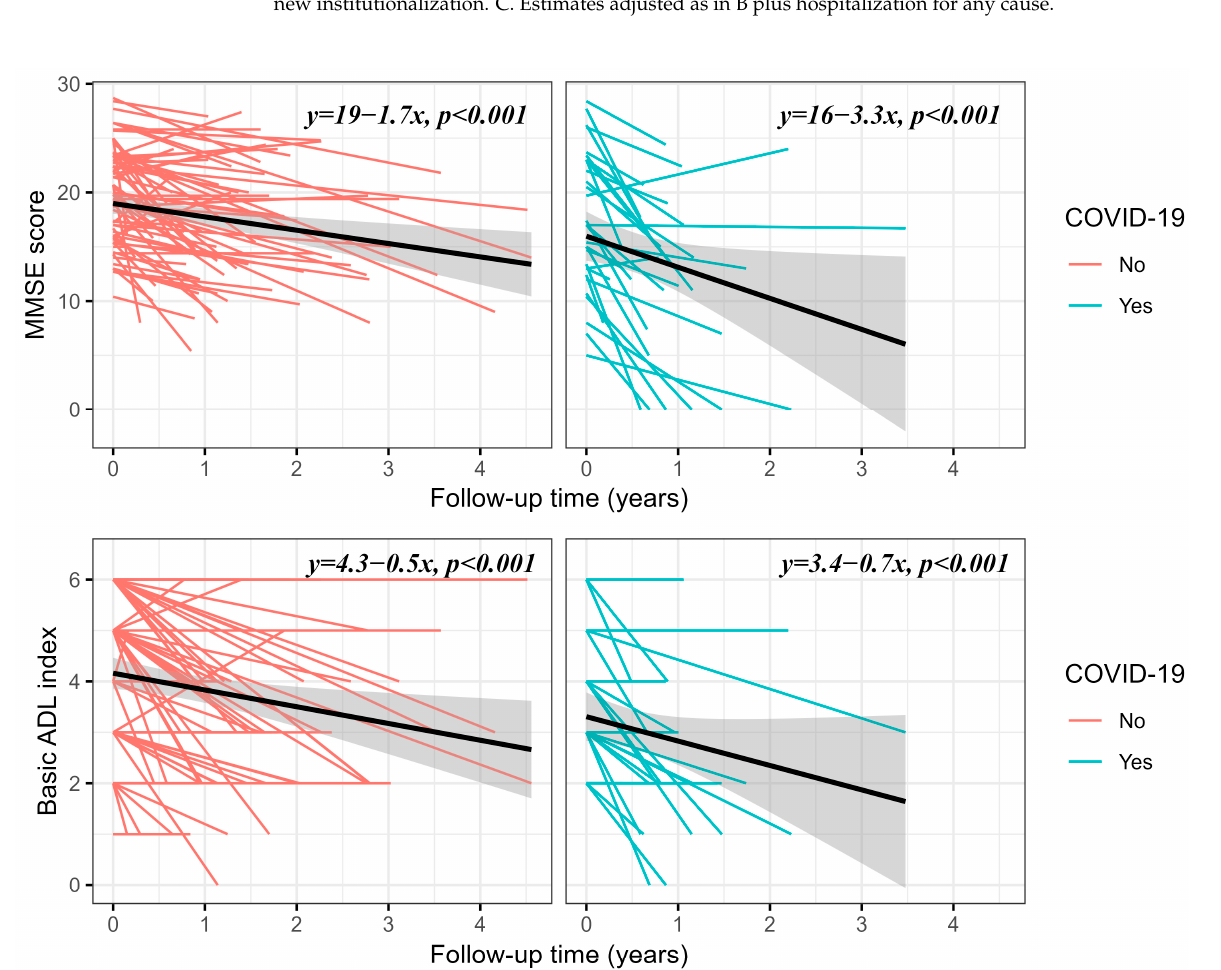
Figure 4. Changes between baseline and follow-up visits of MMSE score, BADL index, and IADL index over time with the summary regression line (black continuous line) and 95% confidence in- terval (gray bands) of patients who had (cyan lines) or did not have (pink lines) COVID-19. In the top right of each rectangle, the equation of the linear regression line is reported with the p -statistic of the slope. 4. Discussion We defined a significant cognitive decline as the reduction of at least five points in the MMSE score, according to Doody et al. [19]. An MMSE score reduction to such an